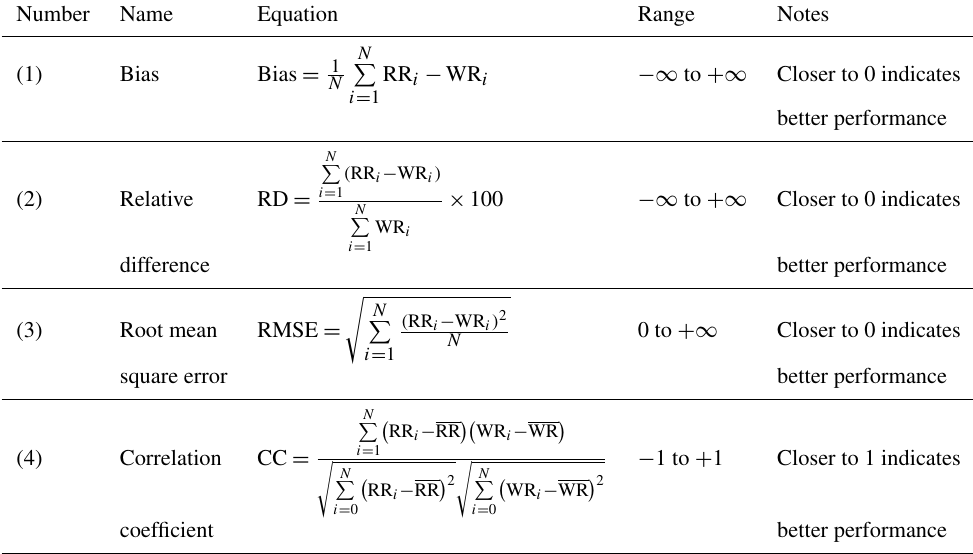
Table 1. Comparison indices used in this study and their equations (partly adopted from Jackson et al., 2019). Number